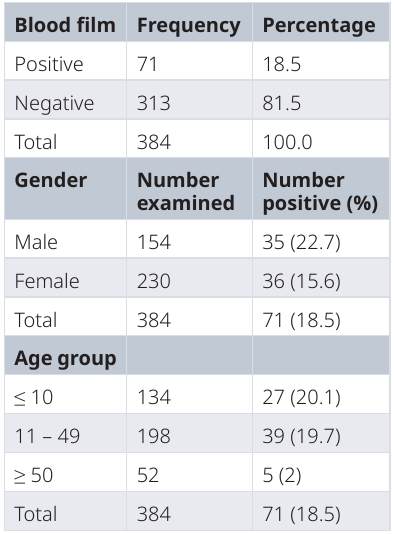
Table 1. Overall prevalence of malaria in study area, assessed using blood